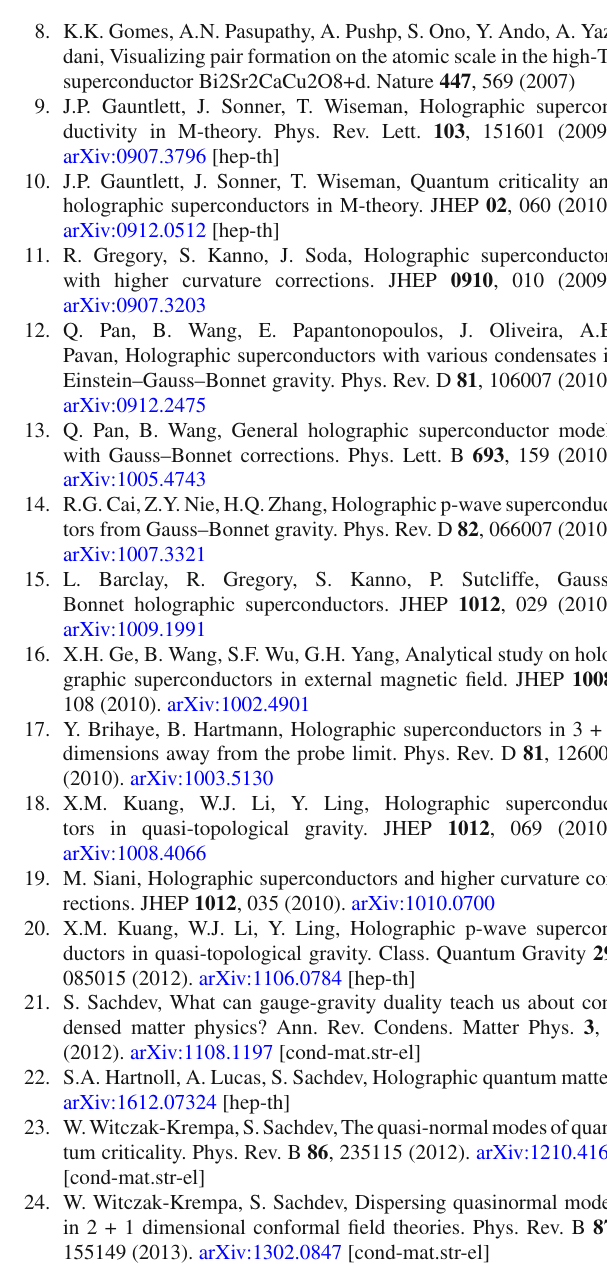
11775036, 11975072, and 11690021, and Fok Ying Tung Education Foundation under Grant no. 171006. Guoyang Fu is supported